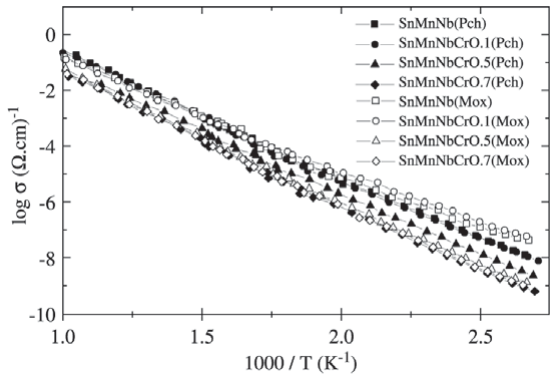
Figure 5. Electrical conductivity normalized to grain size as a func- tion of temperature of system SnMnNbCrx, with 0 ≤ x ≤ 0.7% mol, sintered at 1300 °C for 3 h.